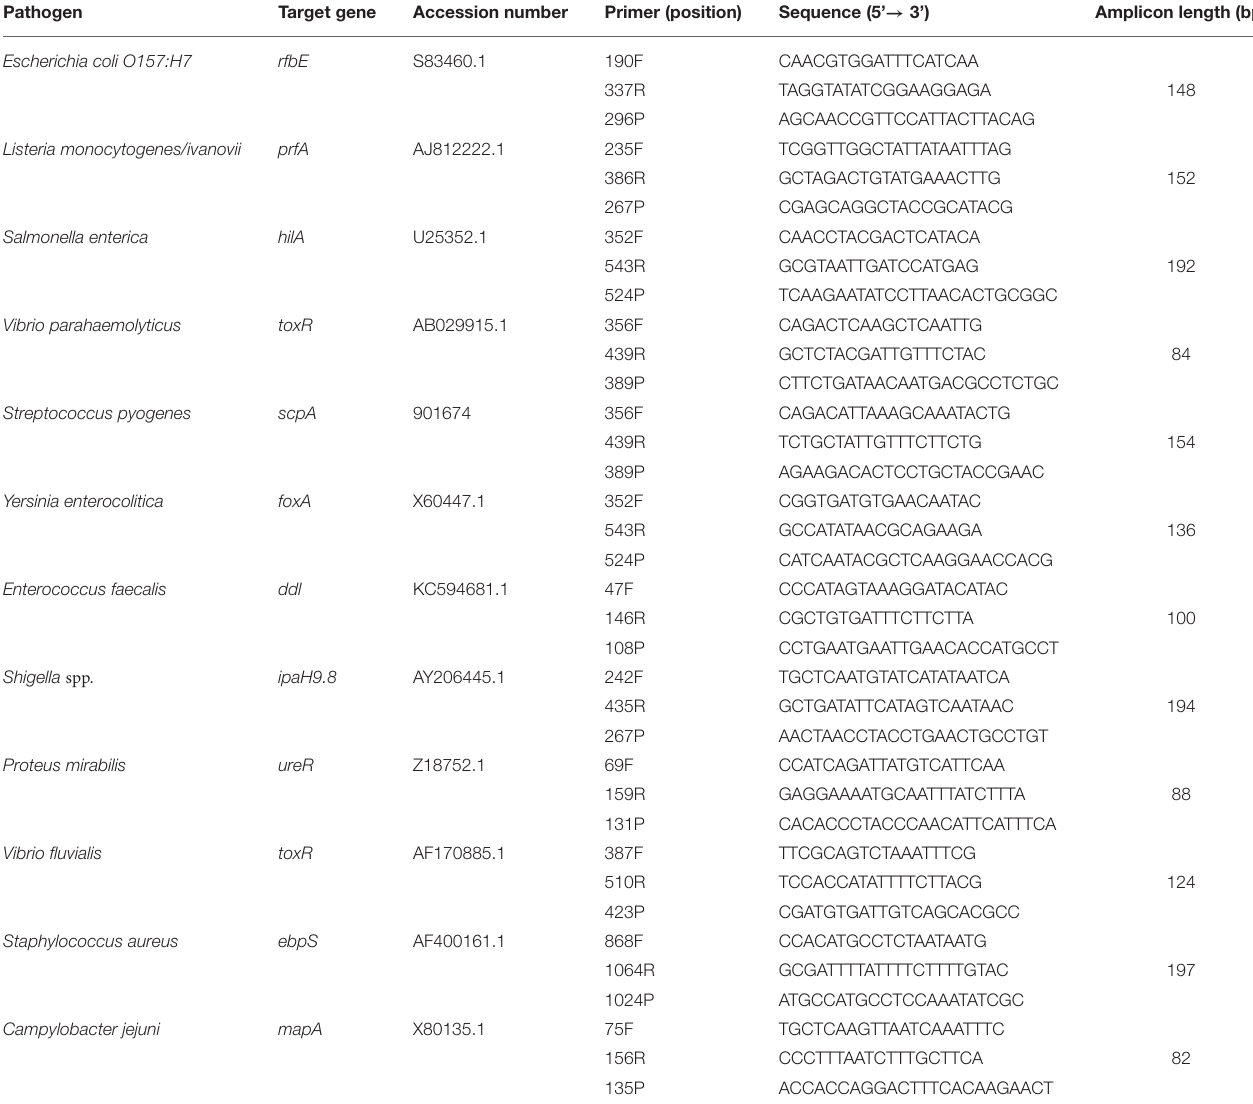
TABLE 1 | Primer and TaqMan probe sequencens used in this